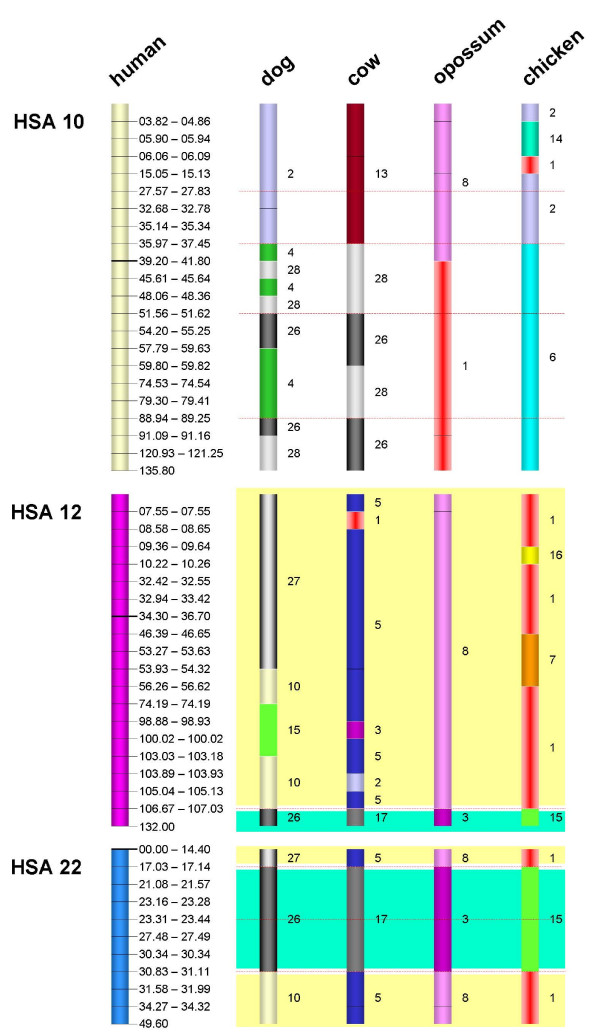
E-painting results for chromosomes HSA10, HSA12 and HSA22. The stippled red lines indicate regions of primate-specific breakpoints. Black lines within the ideograms represent the positions of breaks in synteny which were probably caused by inversions. Unique colour codes link the HSA12q distal segment (Mb 107.03–132.00) and the central 22q segment (Mb 17.14–30.83), representing the smallest eutherian chromosome [10,12] (12b-22b in Figure 2), as well as the segments 12pter-12q (Mb 0–106.67), 22q proximal (Mb 14.4–17.03), and 22q distal (Mb 31.11–49.60) representing a medium-sized eutherian chromosome (12a-22a in Figure 2). In dog and cow, the HSA10p orthologous segment (Mb 0–37.45) bears a colour code that is different from the HSA12 and HSA22 orthologues and hence does not provide any evidence for an evolutionary association. However, the shared synteny on opossum chromosome 8 confirms previously performed chromosome painting data [11,56,60], strongly suggesting common ancestral HSA10p/12pq/22q orthology. The E-painting data from the murids are not informative in this regard.